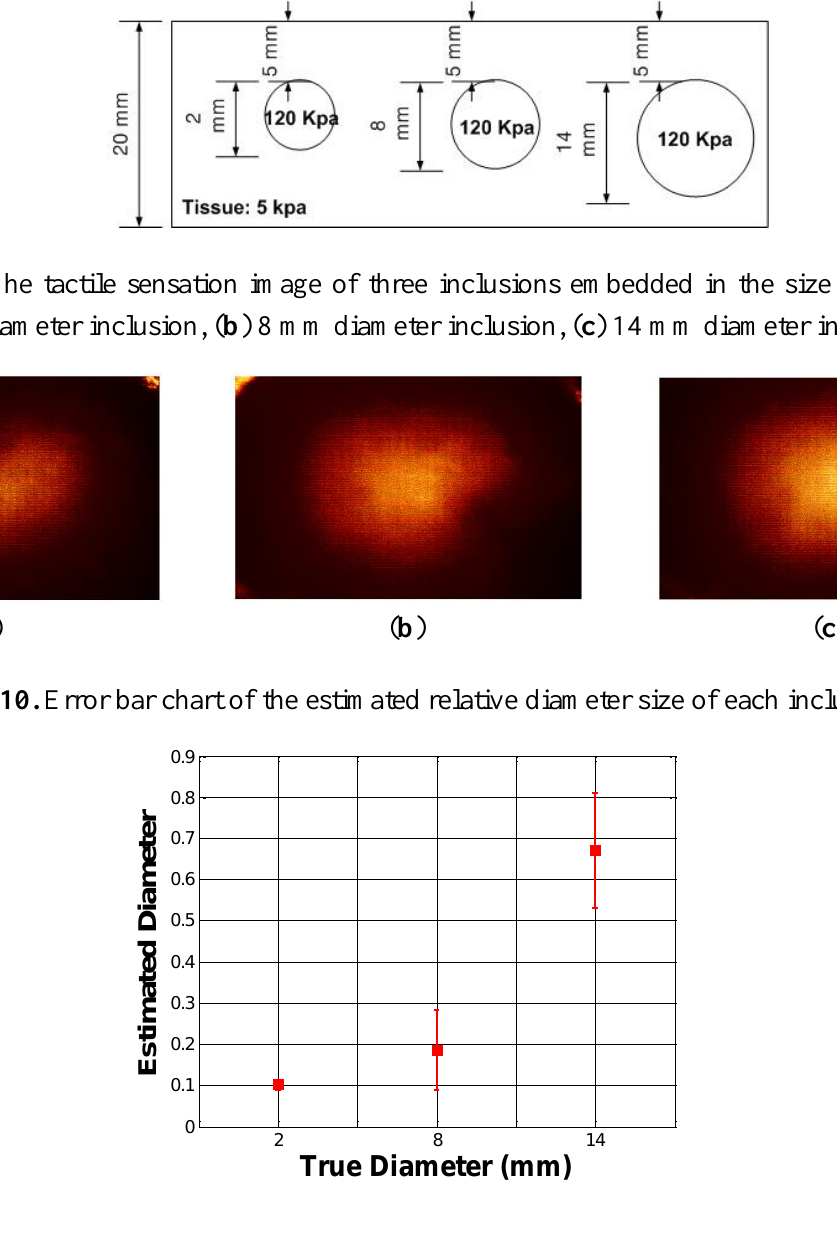
Figure 8. Schematic of the size phantom.